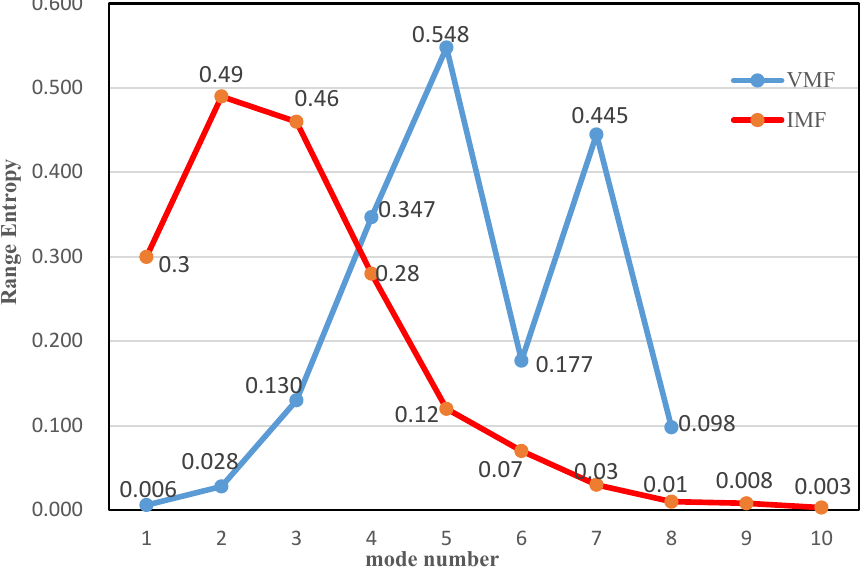
Figure 3. Range entropy analysis of the decomposition of the carbon price.